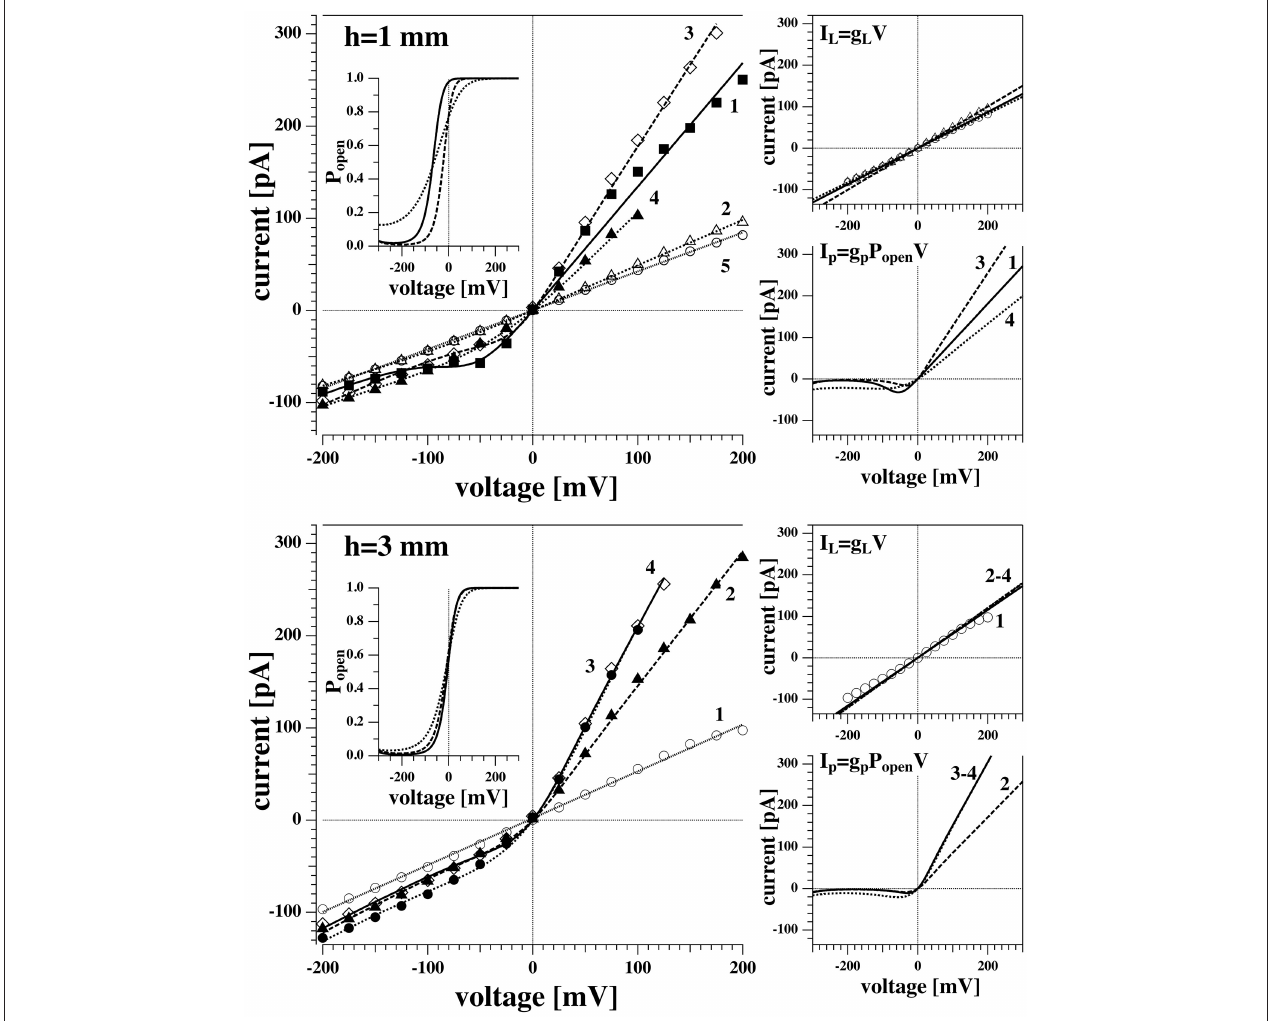
FIGURE 7 | I-V recordings of the same membrane as Figure 5 (membrane 1) at different depths below the air/water interface. (Top) Tip 1 mm below the surface. (Bottom) Tip 3 mm below the surface. Both sets of recordings show two different electrical behaviors, with both linear and non-linear I-V relationships. The curves were measured in sequence and are numbered in order of appearance. Only the average values of the current are displayed for clarity. The dotted lines are fit to all current data points.